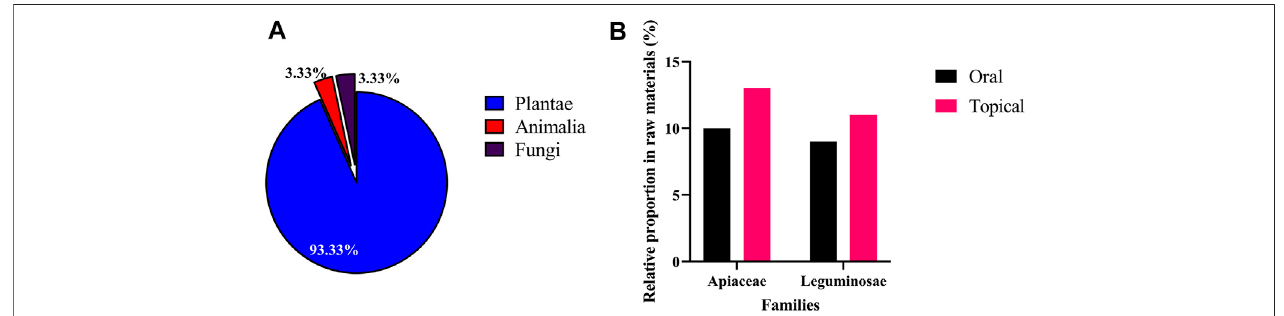
FIGURE 4 | Taxonomy of 90 medicinal materials in 74 skin whitening prescriptions. (A) Kingdoms and (B) families.